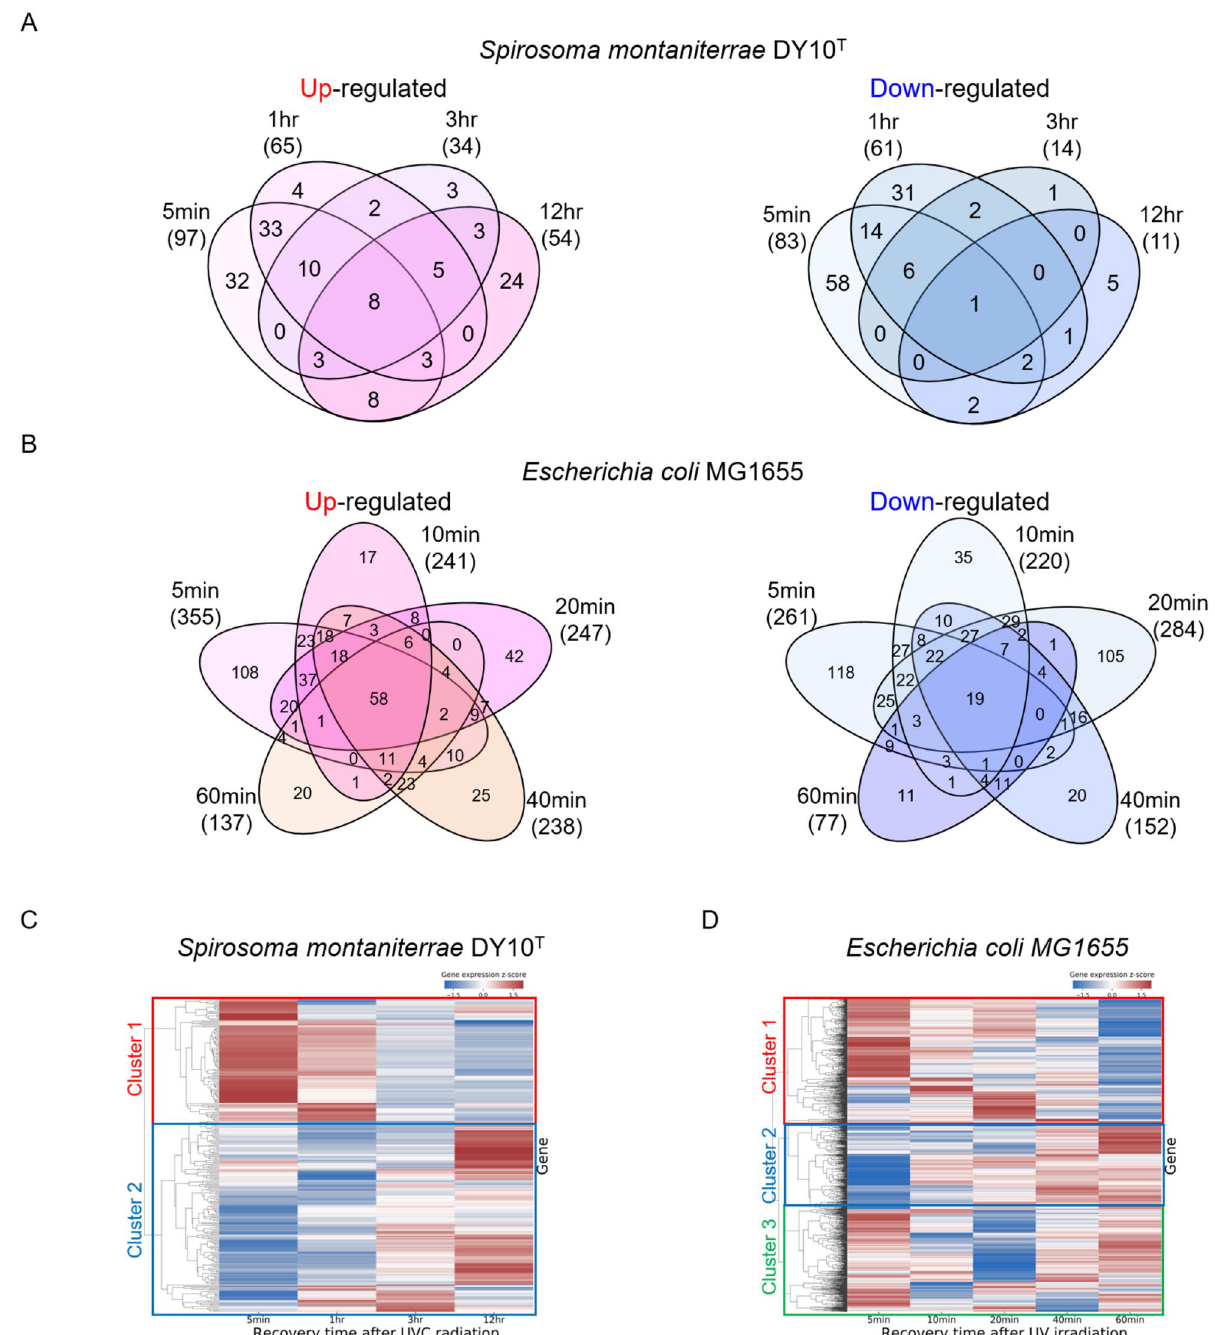
T and Escherichia